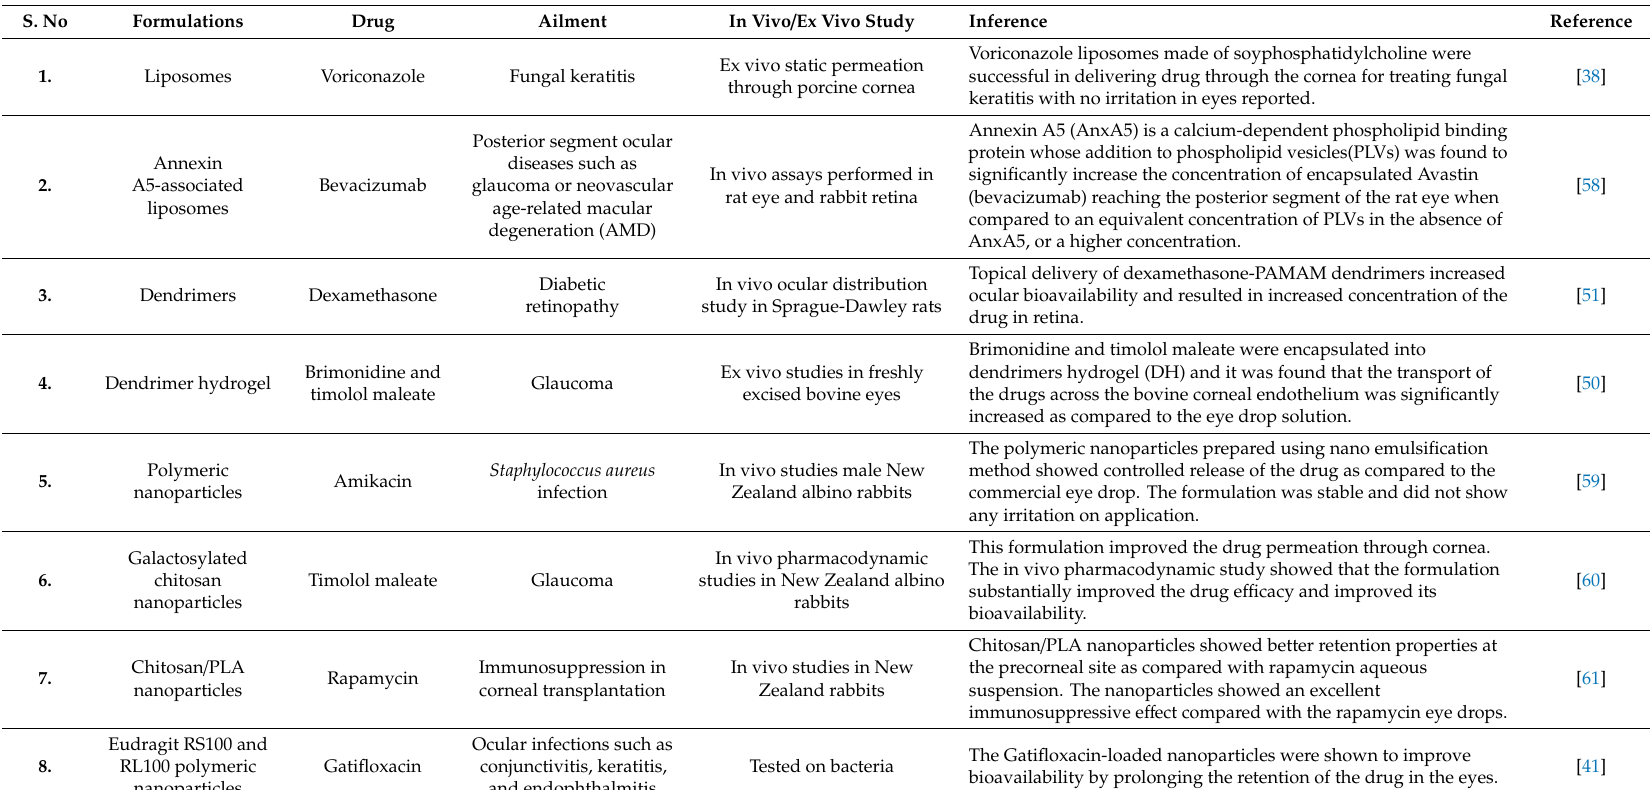
Table 1. Various nanoformulations used for ocular delivery (nonclinical